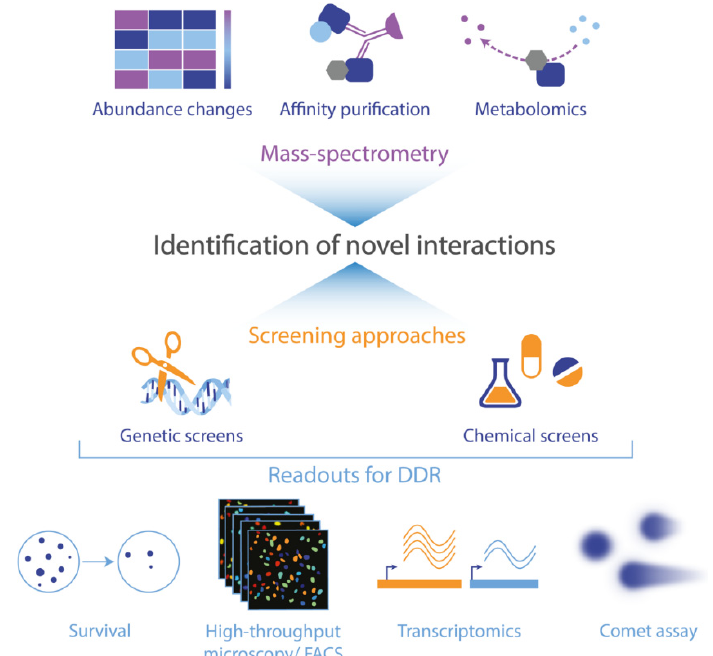
Figure 3. Overview of currently available high-throughput technologies and approaches to discover new crosstalk between metabolism and the DNA damage response (DDR). Proteomics can be used to either quantify the abundance of proteins or post-translational modifications after DNA damage, whereas affinity purification of known DNA repair proteins can identify unknown interactors. Metabolomics can identify metabolites that modulate DNA repair. Genetic or chemical screens utilizing a variety of different readouts, described in more details in the main text, have been developed and represent a useful tool to pinpoint complex interaction networks between metabolism and DDR.